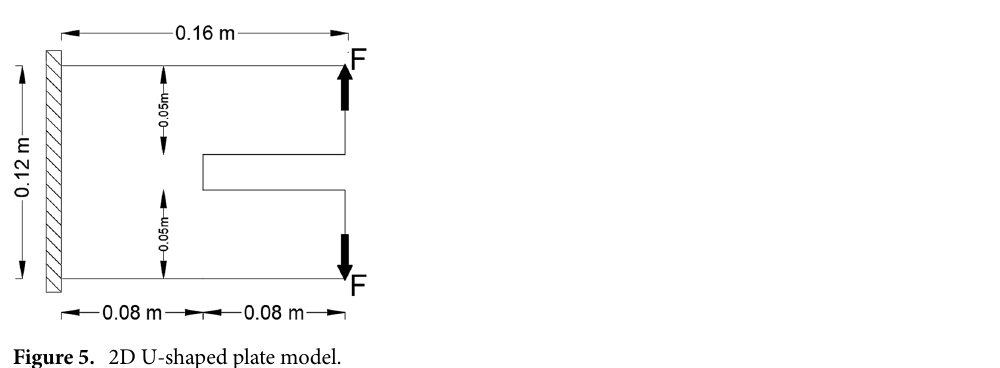
Figure 5. 2D U-shaped plate